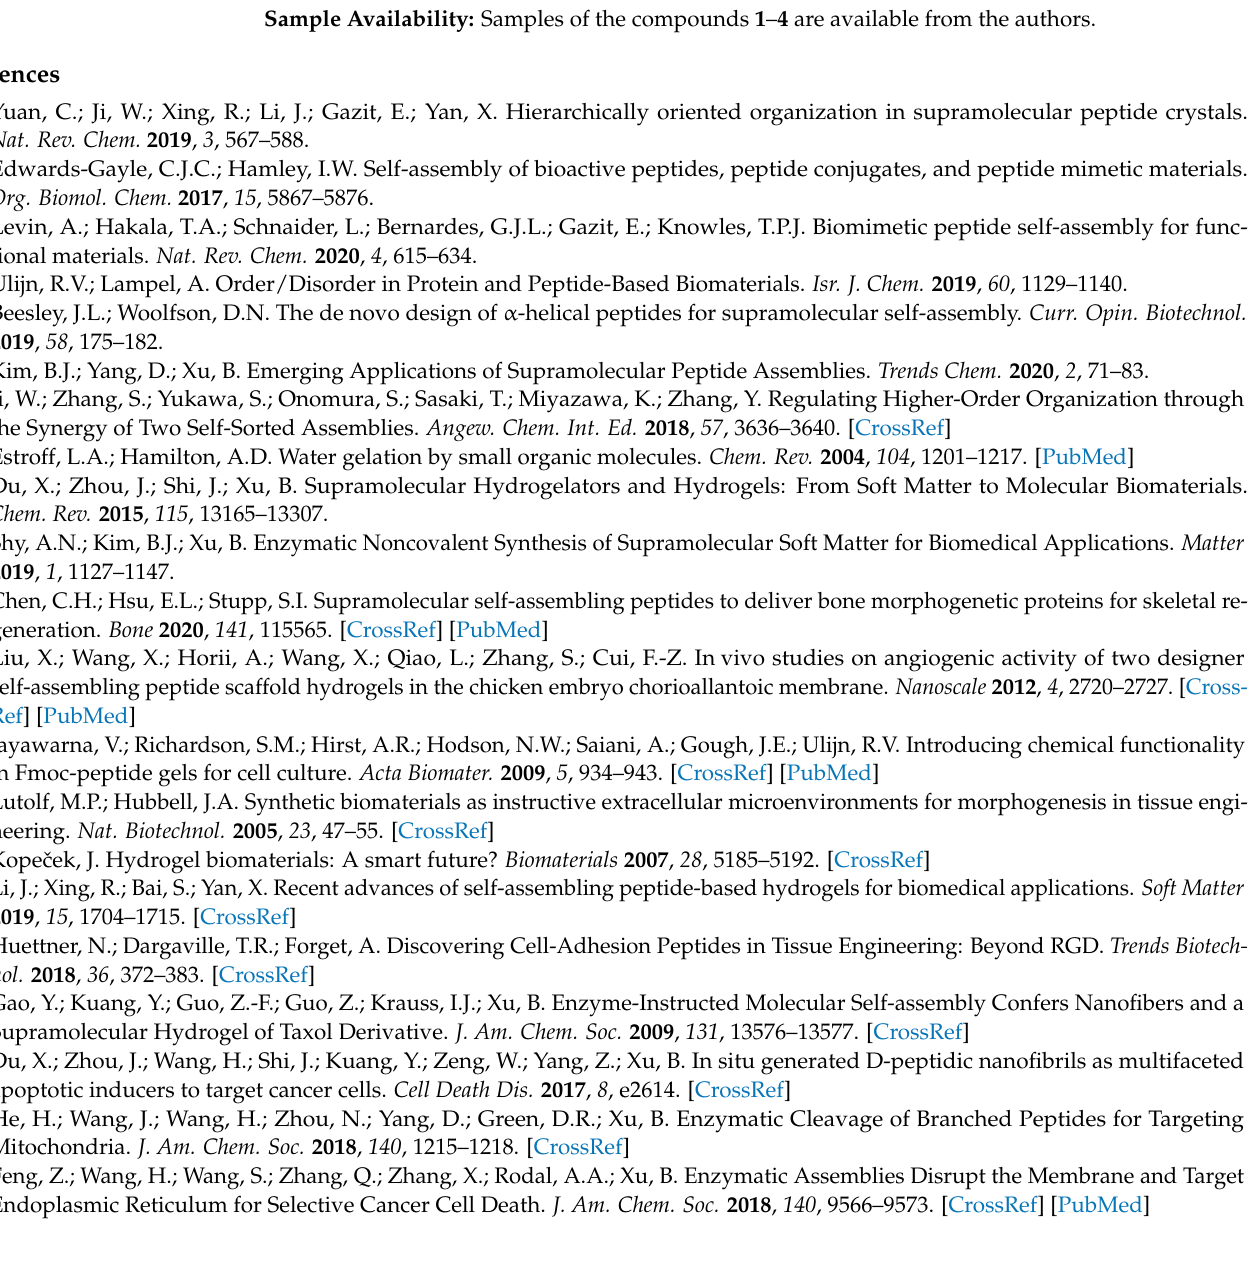
Figure S6: fluorescent spectra of the mixture of 2 and 3 , Scheme S1: synthetic